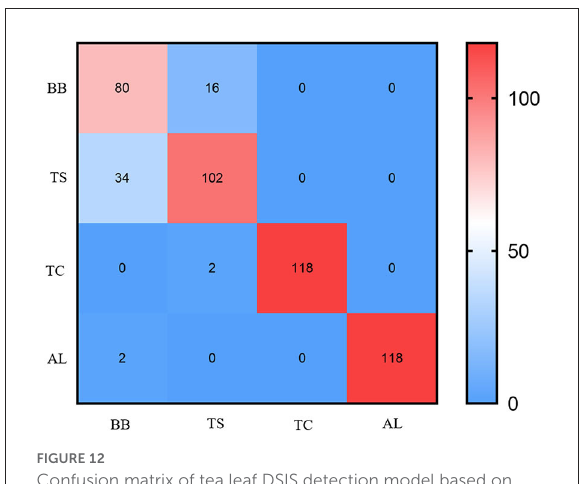
FIGURE12 Confusion matrix of tea leaf DSIS detection model based on